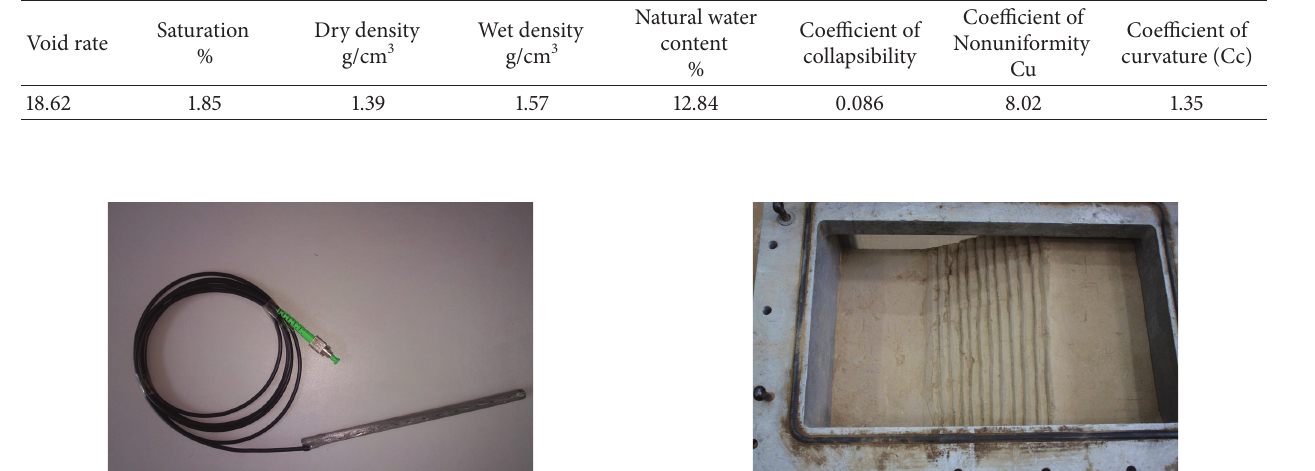
Table 1: Physical properties of the test soil.